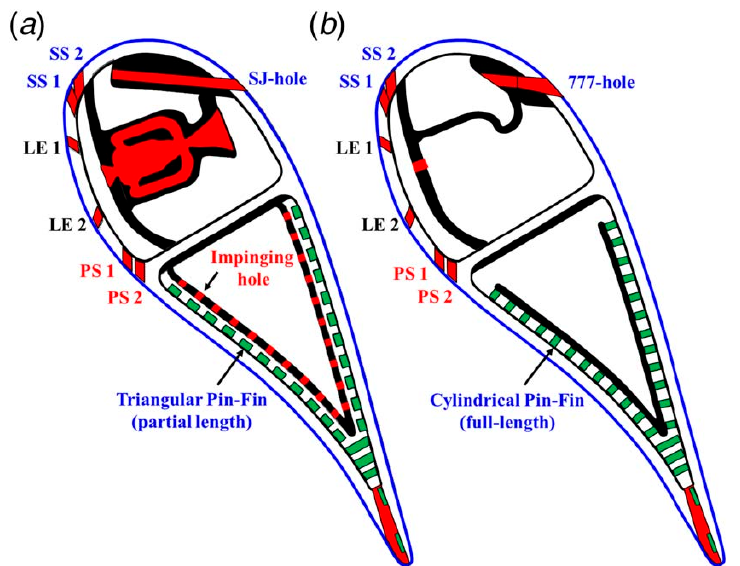
Figure 26. Schematic view of the OSU-vane with different double-wall cooling schemes: ( a ) impingement cooling with sweeping jet hole and ( b ) impingement cooling with circular impingement hole. Reprinted with permission from [115]. Copyright 2021 ASME.